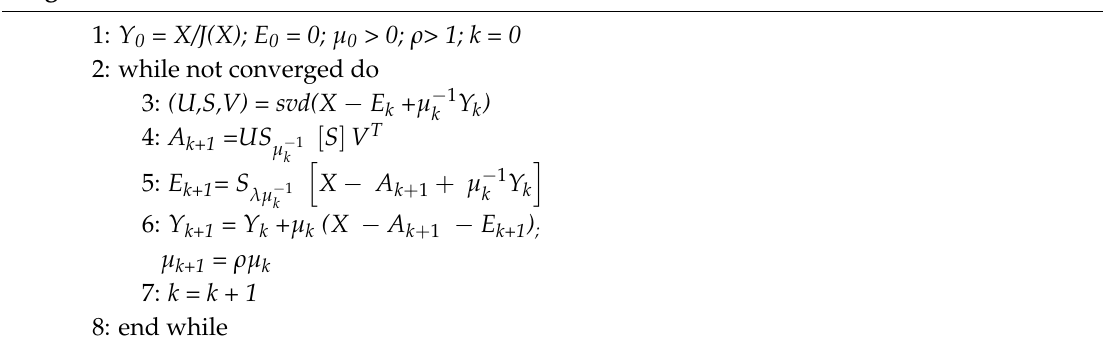
Algorithm 1 Robust PCA via the Inexact ALM